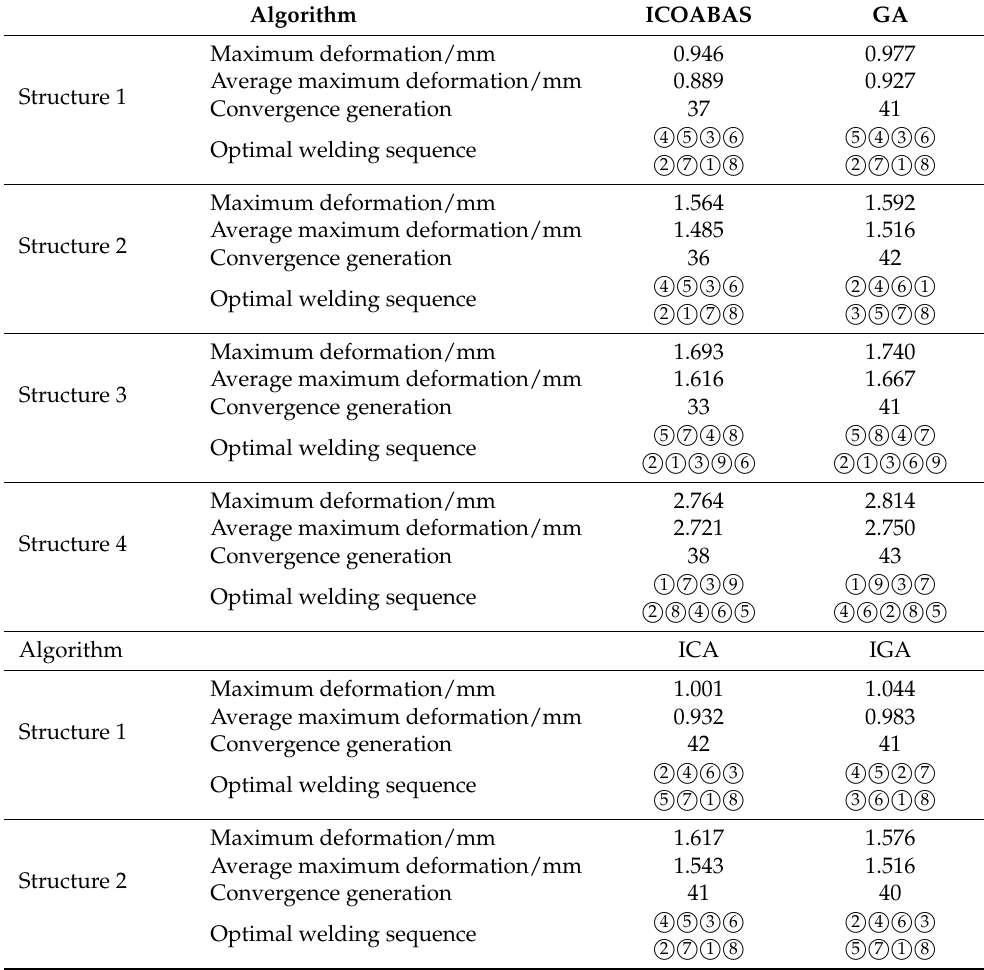
Table 2. Test results of four optimization algorithms for four welded